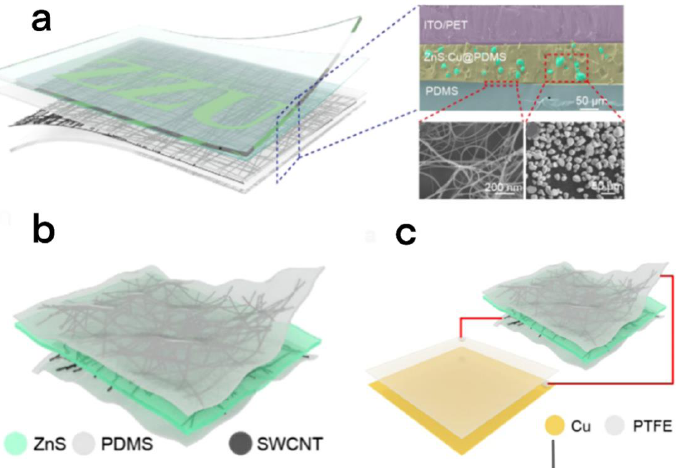
Figure 10. Structure of flexible self-powered display screen. ( a ) Structural diagram of an integrated self-powered transparent ACEL system [78]. Sun et al. (2022), Elsevier. ( b ) Schematic diagram of ACEL device, consisting of two SWCNT transparent electrodes and ZnS: Cu emission layer. ( c ) Conceptual diagram of self-powered ACEL device [79]. Sun et al. (2021), Elsevier. A flexible self-powered display screen has great potential in the fields of IoT and personalized display devices due to its special structure and self-powered characteristics. However, the single black and white color tone greatly limits its commercialization. To solve this problem, Chang et al. integrated TENG with stretchable multicolor AC electro- luminescent (ACEL) devices, and a new self-powered and self-repairing multicolor dis- play was proposed (Figure 11a,d) [81]. This self-powered self-healing multicolor display has a structure with high stretchability and self-healing efficiency by adding reversible dynamic imine bonds to ordinary PDMS (reaching 2500% tensile performance and 96% self-recuperating effectiveness at room temperature); through this special structure (Fig- ure 11c) as electrode substrate and emitter layer matrix, they successfully manufactured naturally stretchable and self-mending ACEL (SSH/ACEL) devices (Figure 11b).